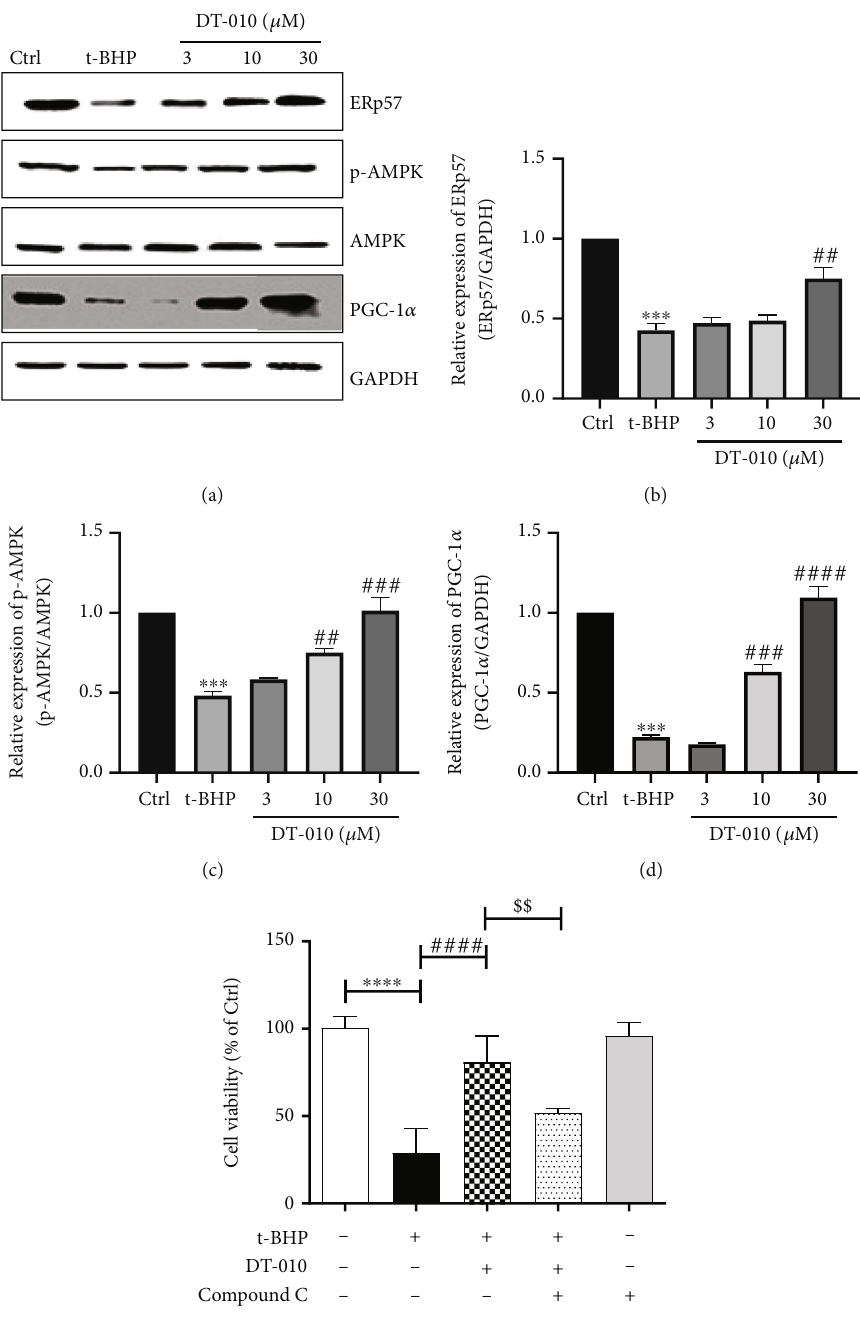
Figure 2: E ff ect of DT-010 on AMPK/PGC-1 α pathway and ERp57 in H9c2 cells. (a – d) DT-010 increased the ERp57 (b), p-AMPK α (c), and PGC-1 α (d) protein expression levels in t-BHP-induced H9c2 cell injury. (e) Cell viability (% of Ctrl) was measured by the MTT assay. Data are mean ± SD of two or three independent experiments. ∗∗∗ P < 0 : 001 and ∗∗∗∗ P < 0 : 001 versus the Ctrl group; ## P < 0 : 01 , ### P < 0 : 001 , and #### P < 0 : 0001 versus the t-BHP group. $$ P < 0 : 01 . Data were analyzed using one-way ANOVA and Dunnett ’ s multiple comparison test (b – d) or Tukey ’ s multiple comparison tests